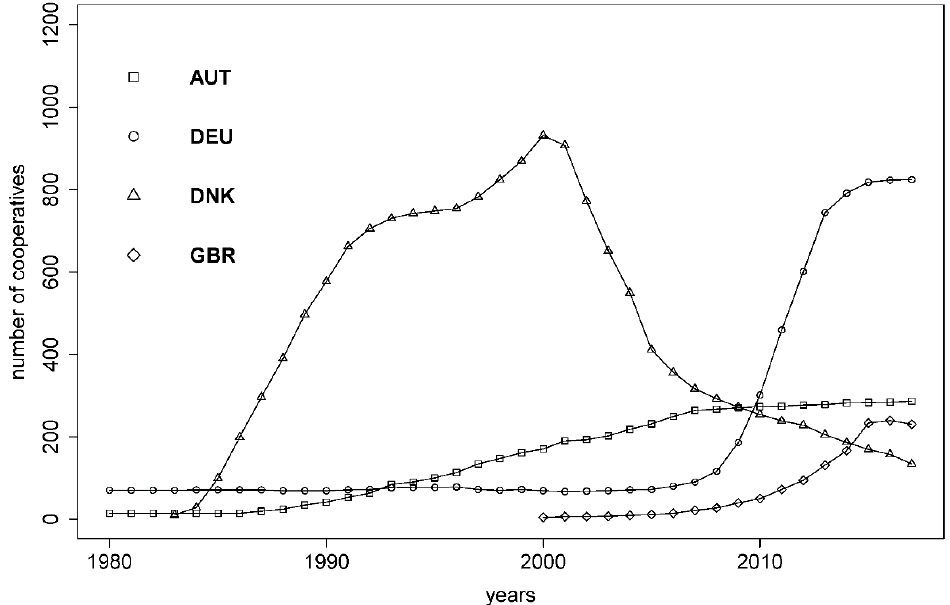
Figure 1. The number of energy cooperatives in Austria, Germany, Great Britain, and Denmark [1].